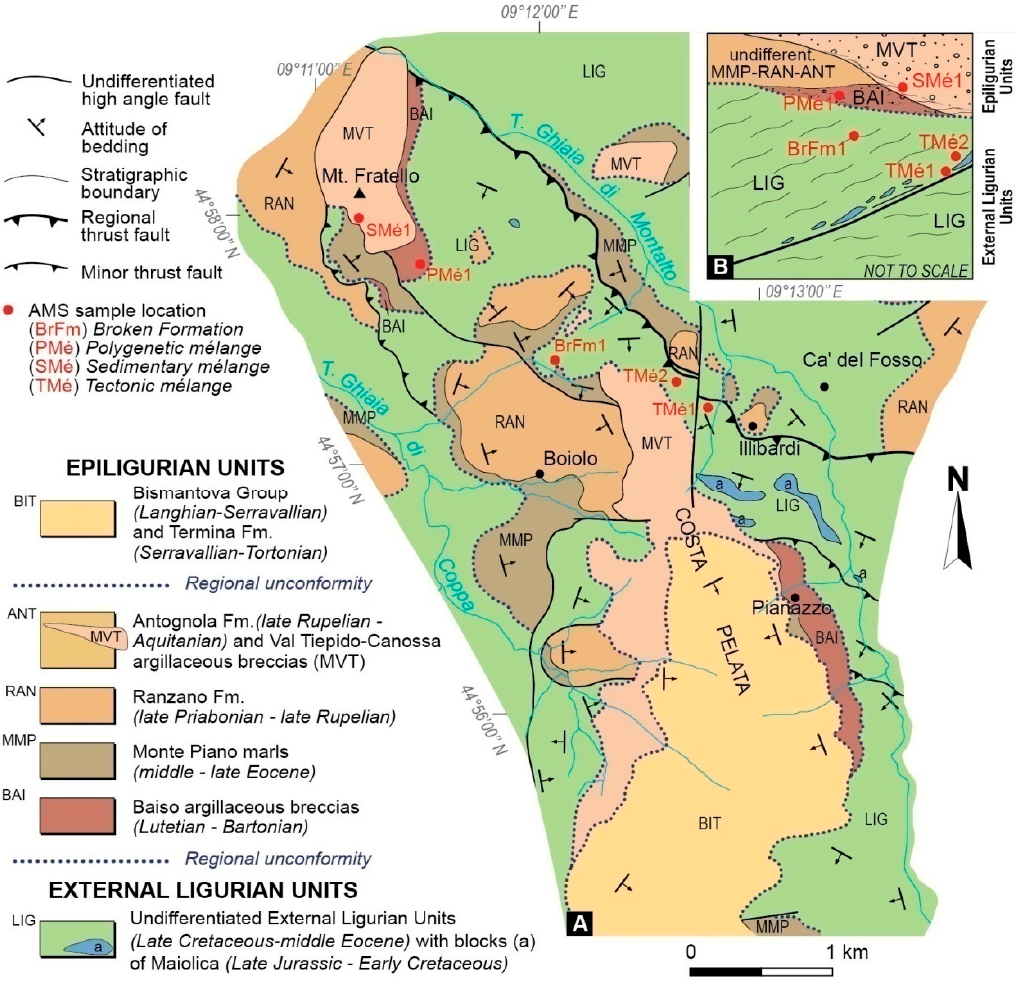
Figure 2. Simplified geological-structural map of the Voghera sector of the Northern Apennines (modified from [33,87]) ( A ) with location of the anisotropy of magnetic susceptibility (AMS) samples. ( B ) Schematic column (not to scale) showing the vertical piling of the different mélange and broken formation units and locations of AMS samples.